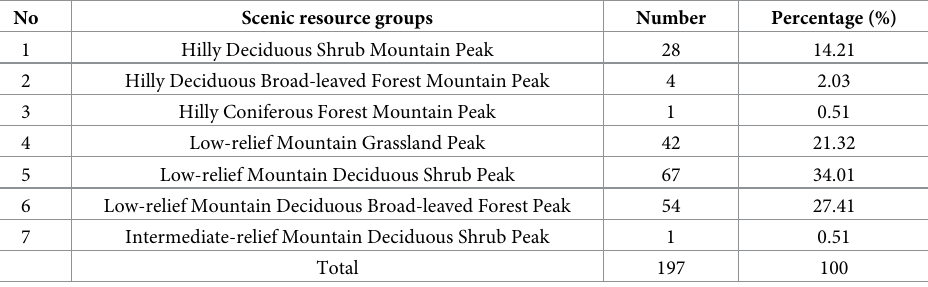
Table 6. Scenic resource groups of